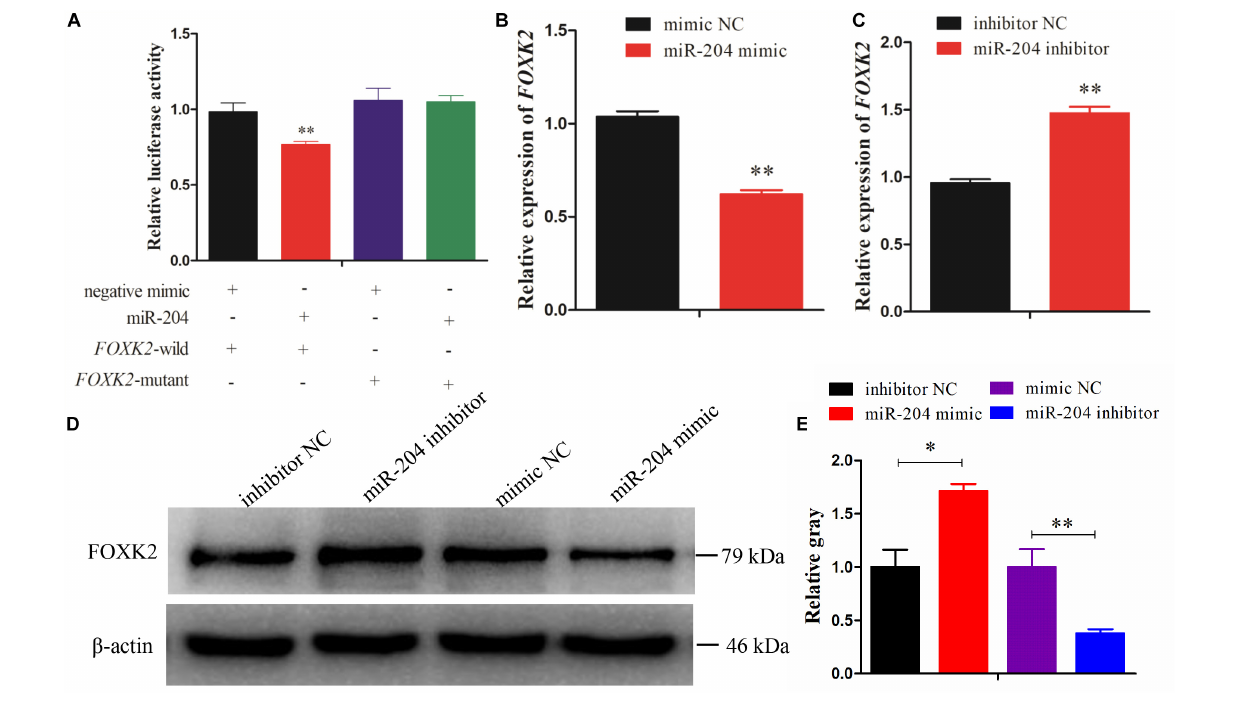
FIGURE 4 | Forkhead box K2 (FOXK2) is a target gene of miR-204. (A) Chicken DF-1 cells were co-transfected with FOXK2-3 (cid:48) -untranslated region (UTR) wild or mutant dual-luciferase vector and the miR-204 mimic or miR-negative control (NC). The relative luciferase activity was assayed 48 h later. (B, C) The mRNA expression of FOXK2 in chicken granulosa cells (GCs) was detected by quantitative real-time PCR (qRT-PCR) after overexpression and inhibition of miR-204. (D, E) The protein expression of FOXK2 in chicken GCs was detected by Western blot analysis after a gain or loss of miR-204. Replications = 3. Data are presented as mean ± SE; * P < 0.05 and ** P < 0.01. miR,